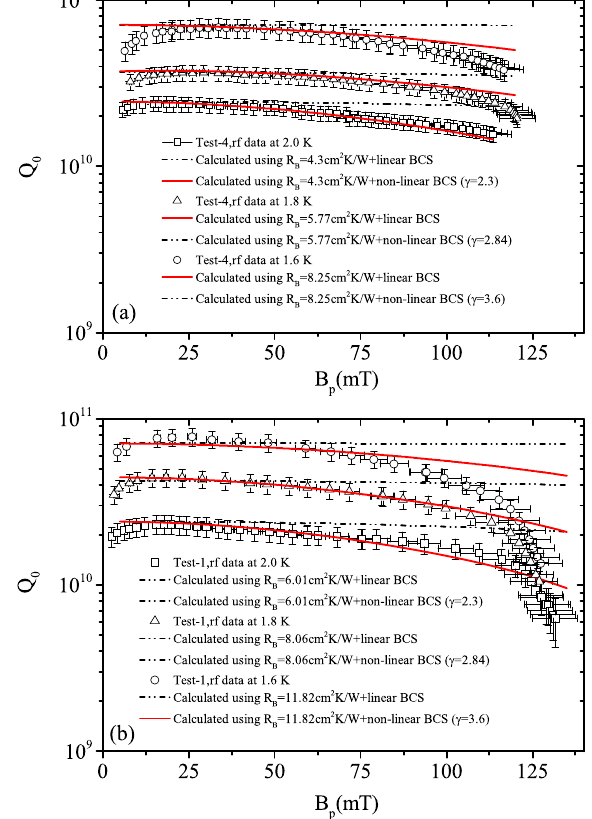
FIG. 10. Comparison between measured and calculated ð B Þ curves for cavity TD5 (a) and RDT13 (b) using the Q 0 p TFBM with the measured thermal resistance for the cases of linear ( – ) and nonlinear BCS resistance (-) as described in the